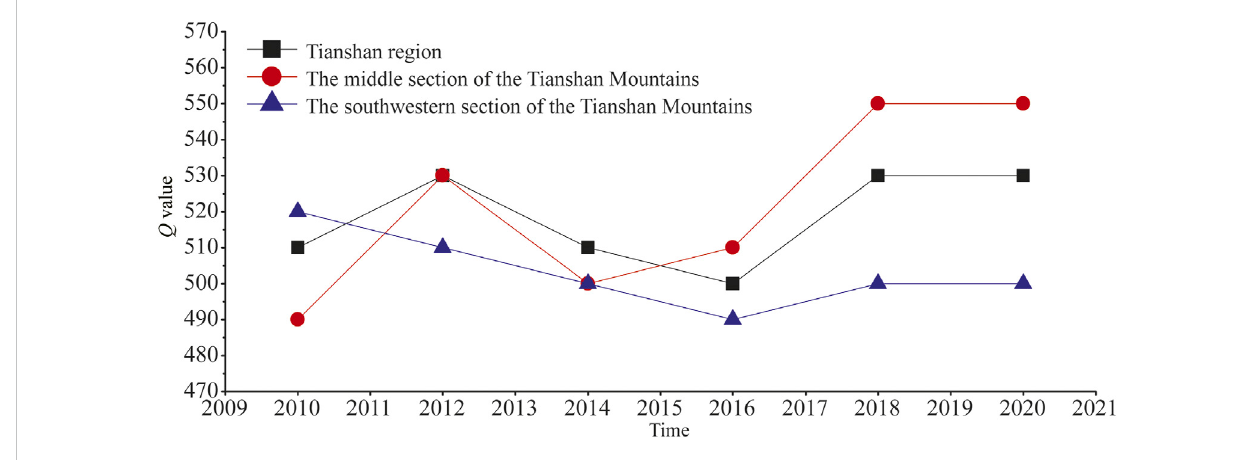
FIGURE 9 Temporal variations in the regional average Q values in the Tianshan tectonic belt (TTB), middle Tianshan (zone V 1 ), and southwestern Tianshan (zone V 2 )